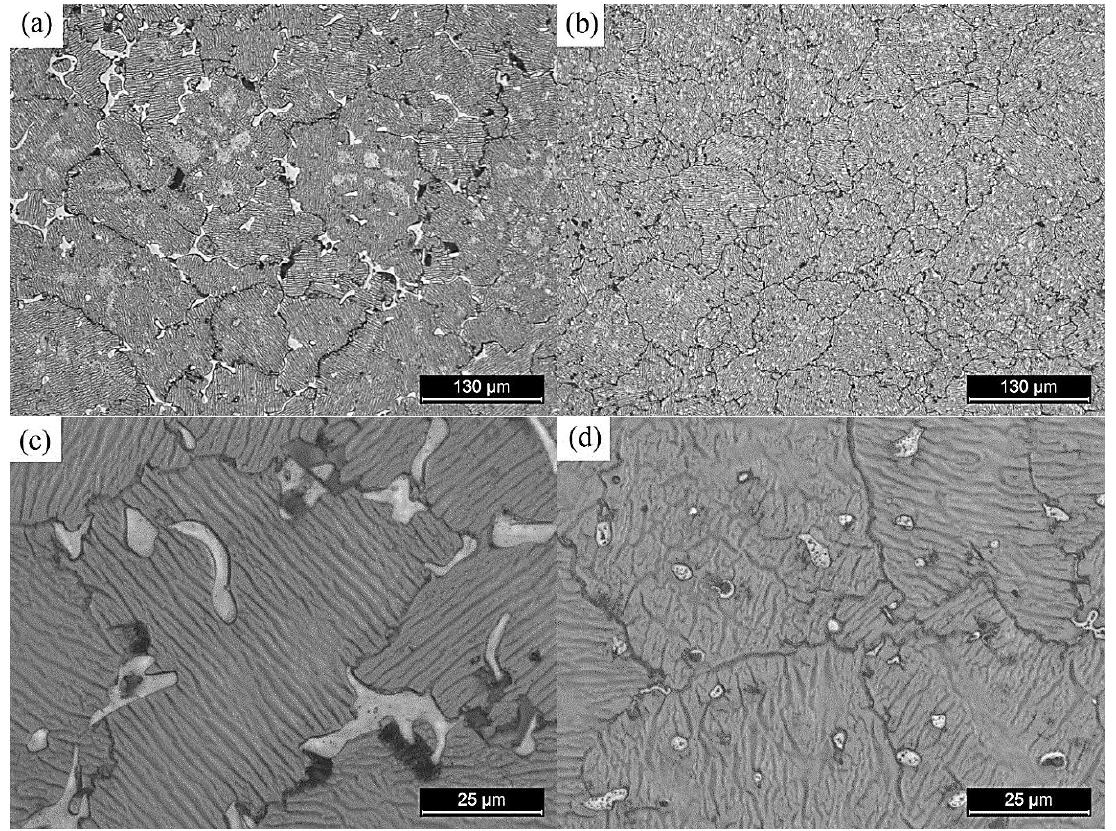
Figure 2. As-cast microstructures of AZ91D: ( a , c ) non-treated samples; ( b , d ) US treated samples.